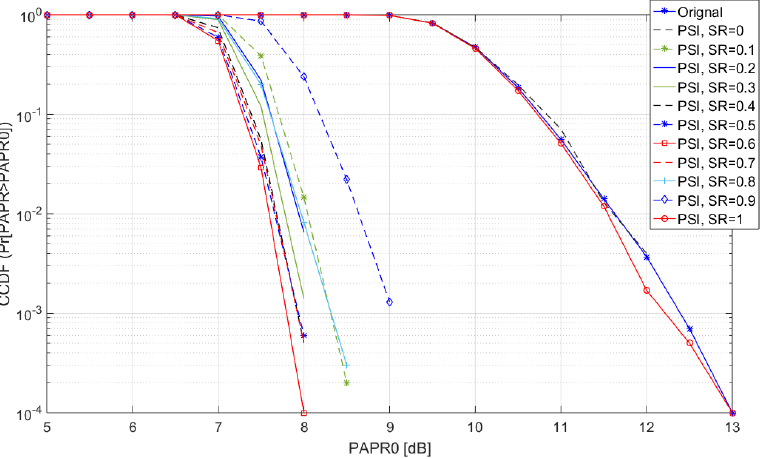
Figure 10. CCDF result versus SR